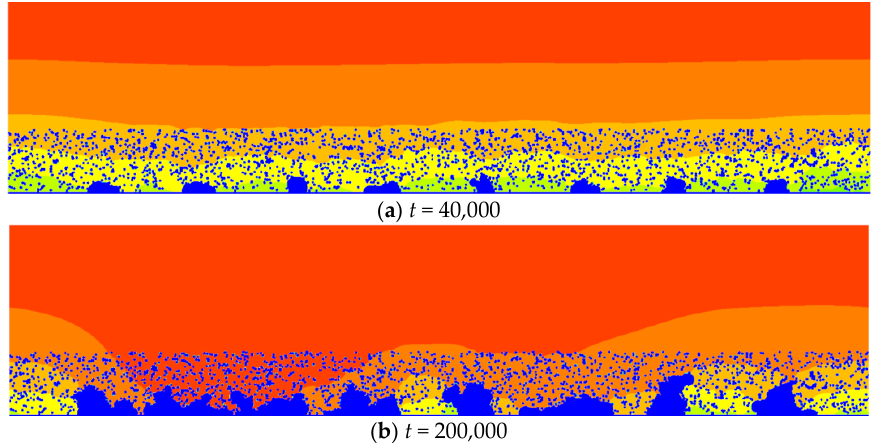
Figure 7. Time evolutions of liquid water distribution in the domain with eight fractures.